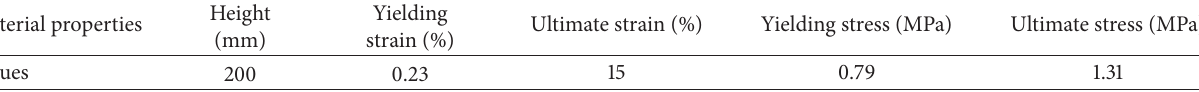
Table 1: Material properties of the Kagome truss damper.